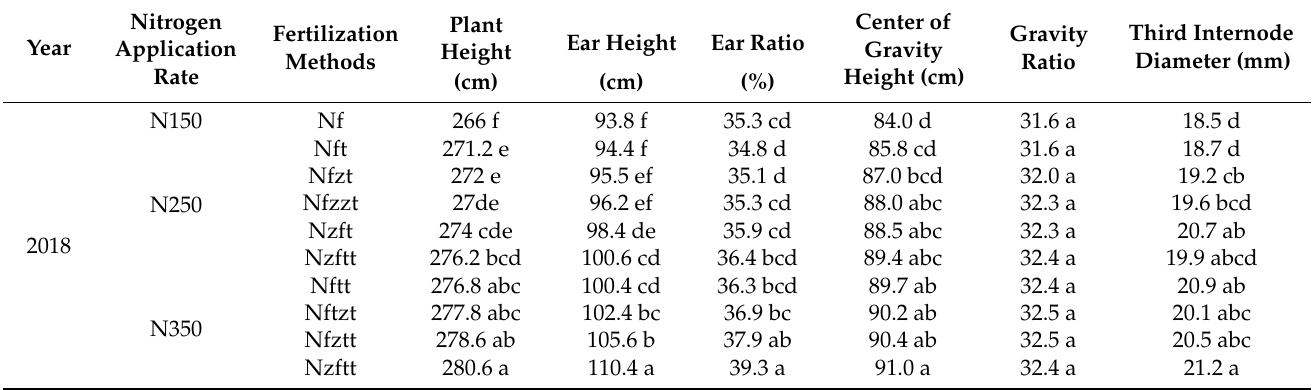
Table 3. Effect of the fertilization methods on the morphology of plant and basal internode under different nitrogen application